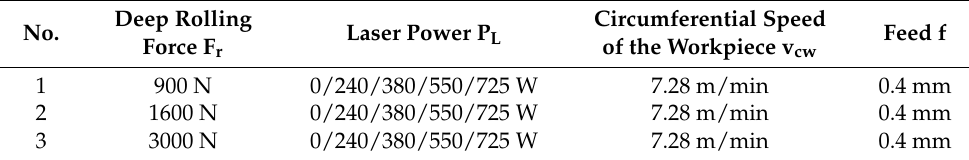
Table 2. Parameters for laser-combined deep rolling process.